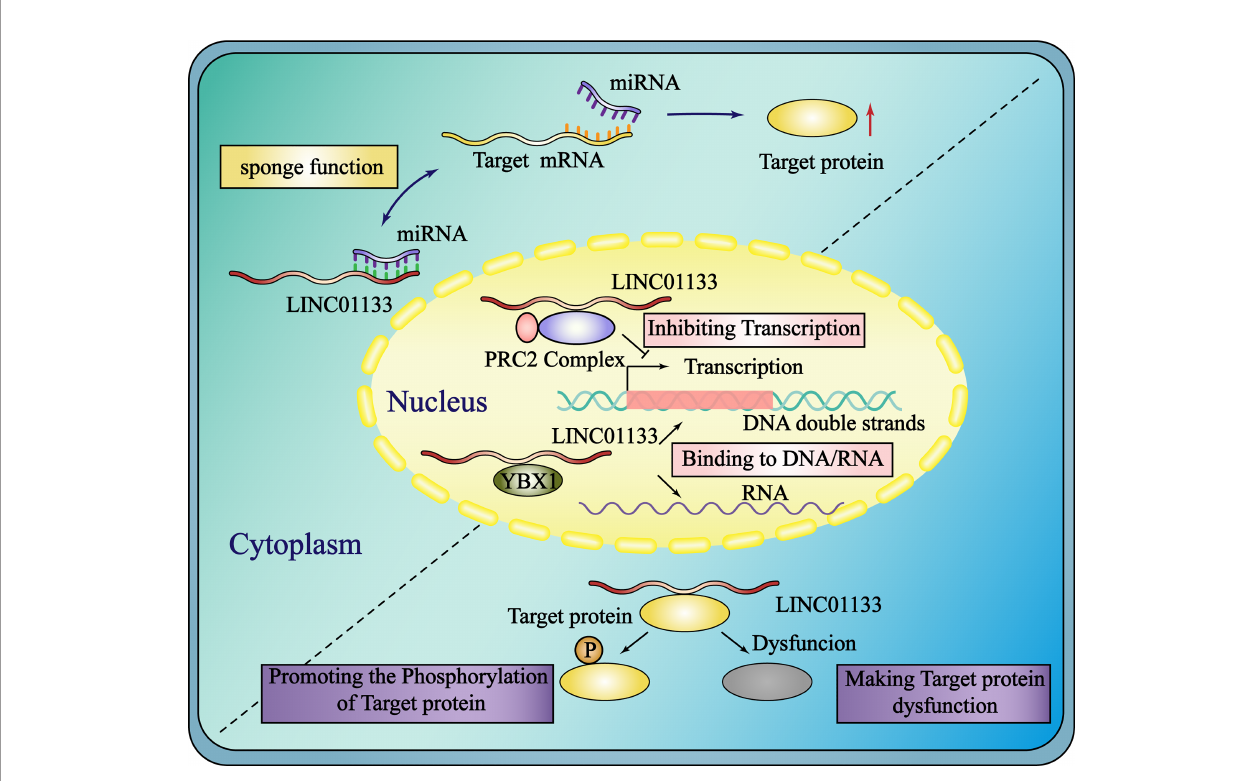
FIGURE 1 | Subcellular localization and function of LINC01133. In the cytoplasm, LINC01133 functions by the mechanisms of ceRNA and binding to RBPs which promotes the phosphorylation of target protein or makes it dysfunction. In the nucleus, LINC01133 functions by the mechanisms of inhibiting transcription and binding to DNA or RNA. The blue rectangle represents the cytoplasm and the yellow oval represents the nucleus. The black dashed line separates the different mechanisms of LINC01133 in the